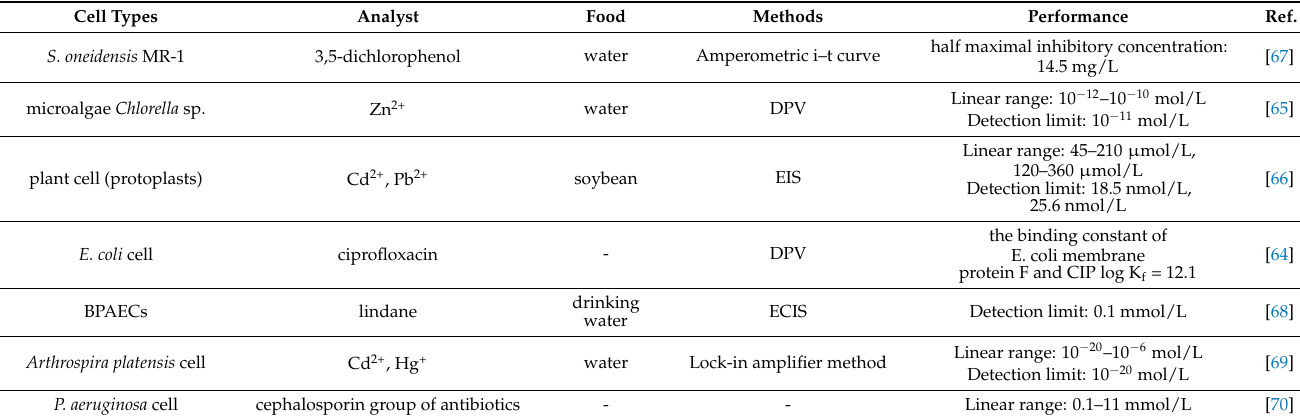
Table 4. Application of cell-based electrochemical sensors in the detection of antibiotics, agricultural and veterinary drug residues, toxic compounds and heavy metals in food.